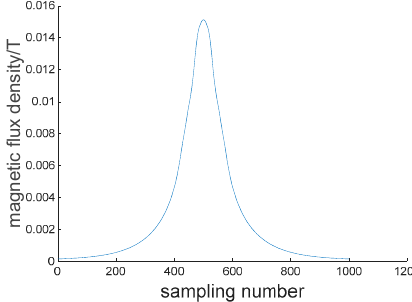
Figure 5. Magnetic field over the longitudinal crack.